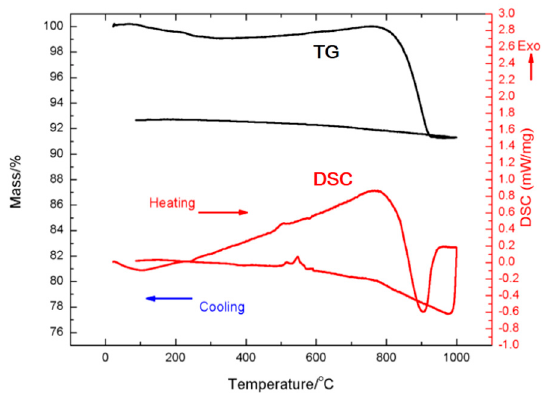
Figure 5. TG-DSC of K 8 Al 8 Si 38 measured from 25 ◦ C to 1000 ◦ C heating and then cooling under flowing argon. Reprinted with permission from Sui, F.; Kauzlarich, S.M. Tuning Thermoelectric Properties of Type I Clathrate K 8-x Ba x Al 8+x Si 38-x through Barium Substitution. Chem. Mater. 2016 , 28 , 3099–3107 [37]. Copyright (2016) American Chemical Society.